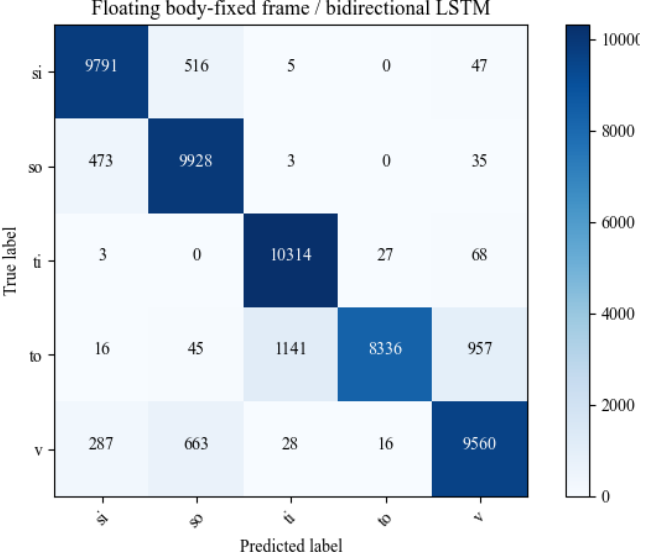
Figure 8. Resultant confusion matrix for the hand-guiding gesture recognition realized through the bi-directional LSTM model. Table 2. Comparison of training and test accuracy of bi-directional LSTM model for the floating body-fixed frame method according to the change in time-horizon length.